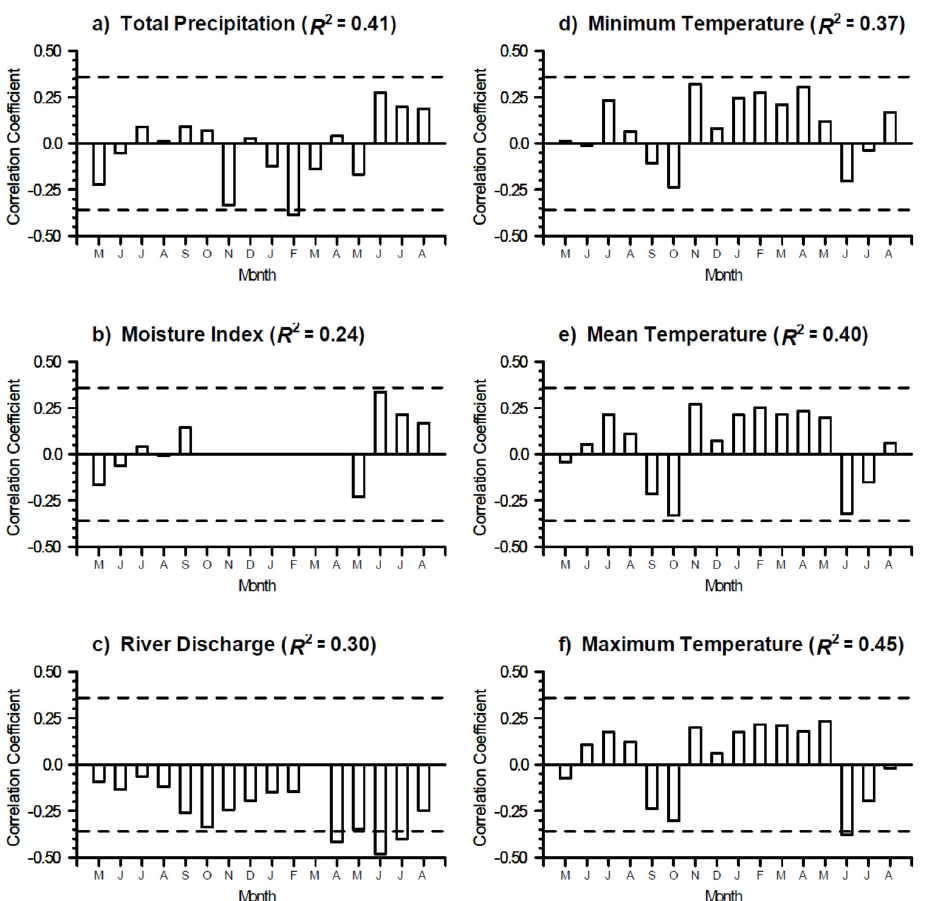
Figure 3. Pearson correlation coefficients between the residual chronology of white spruce and ( a ) total precipitation; ( b ) moisture index; ( c ) river discharge; ( d ) minimum temperature; ( e ) mean temperature; and ( f ) maximum temperature. Significant correlations ( p < 0.05) determined from correlation analysis extend past dashed lines. No climatic variables were deemed significant according to the response function analysis. The R 2 value of the response function model for each climate variable is indicated.